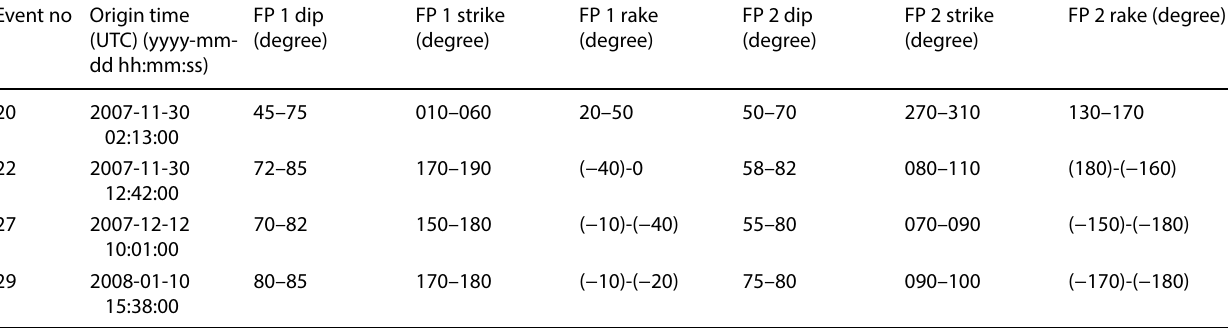
Table 1 Focal mechanism determination with dip, strike, and rake angles for the two fault plane solutions (FP1 and FP2) for four earthquake events; from [64] Event no Origin time (UTC)